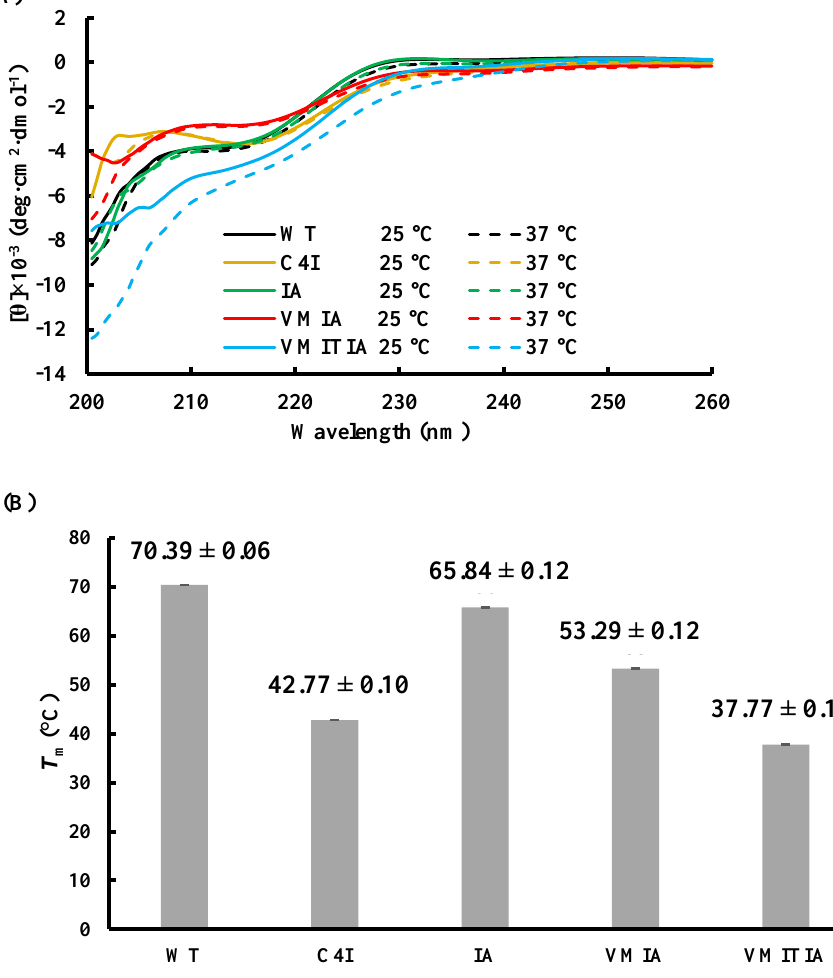
Figure 5. Thermal stability of the DENV3-ED3 variants. ( A ) Far-UV CD spectrum of the DENV3-ED3 variants; ( B ) melting temperature of the DENV3-ED3 variants monitored by thermal denaturation CD at 220 nm. The melting temperature ( T m ) was determined by fitting the thermal denaturation curve with a two-state model. Fitting errors are